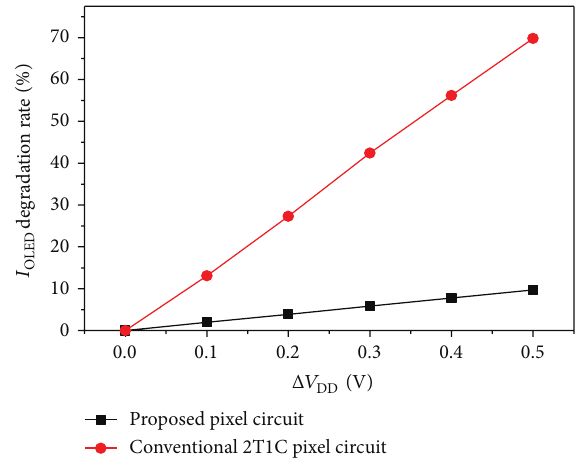
Figure 8: Proposed pixel circuit 𝐼 with the degradation rate of conventional 2T1C pixel circuit, when the range of the 𝐼 × 𝑅 drop voltage of a power line (Δ𝑉